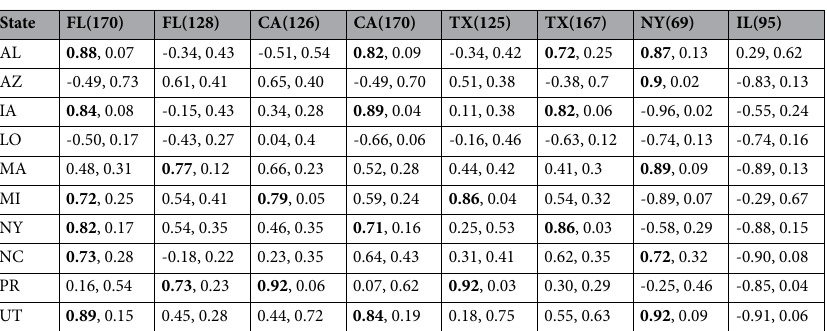
Table 2. (Mean, standard deviation) of Pearson correlation between each weighted out-degree centrality ( F − ( u ) ) spreader (column) curve and a weighted in-degree centrality - out-degree centrality ( F + ( u ) − F − ( u ) ) curve of affected zones (row) over 10-, 20- and 30-day windows, where correlation ≥ 0.7 is marked in